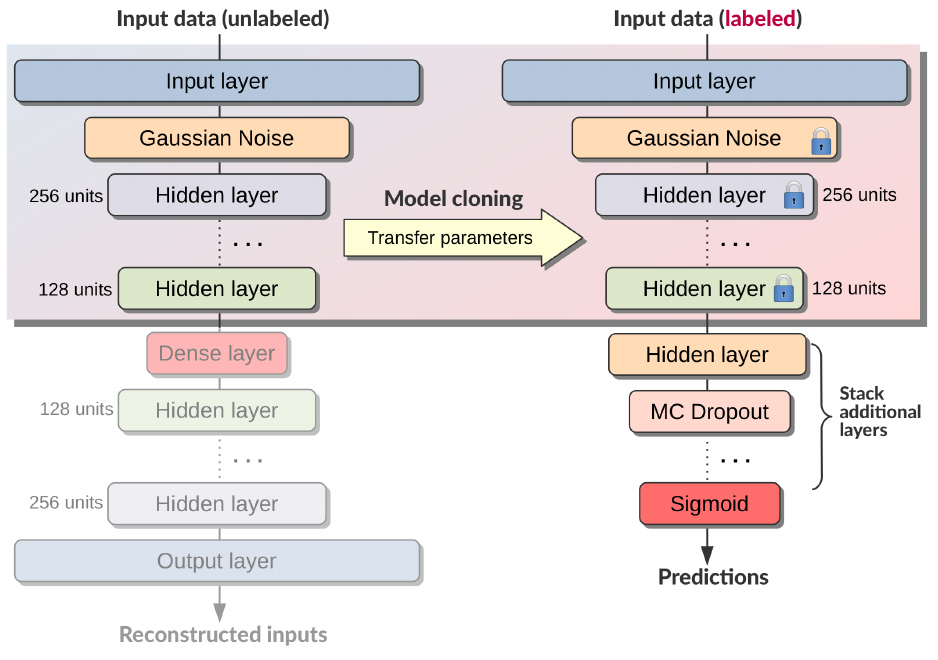
Figure 7. Building a DNN classifier, by means of a transfer learning process, from the clone of the pretrained undercomplete denoising stacked